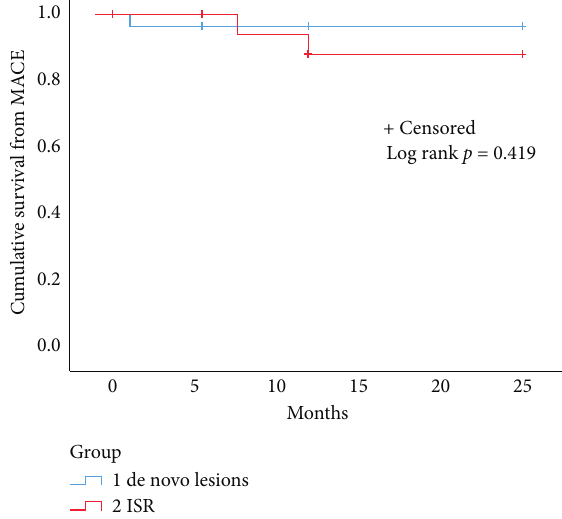
Figure 5: Kaplan–Meier curve of survival from the secondary study endpoint, MACE, at the longest available follow-up. MACE � major cardiovascular